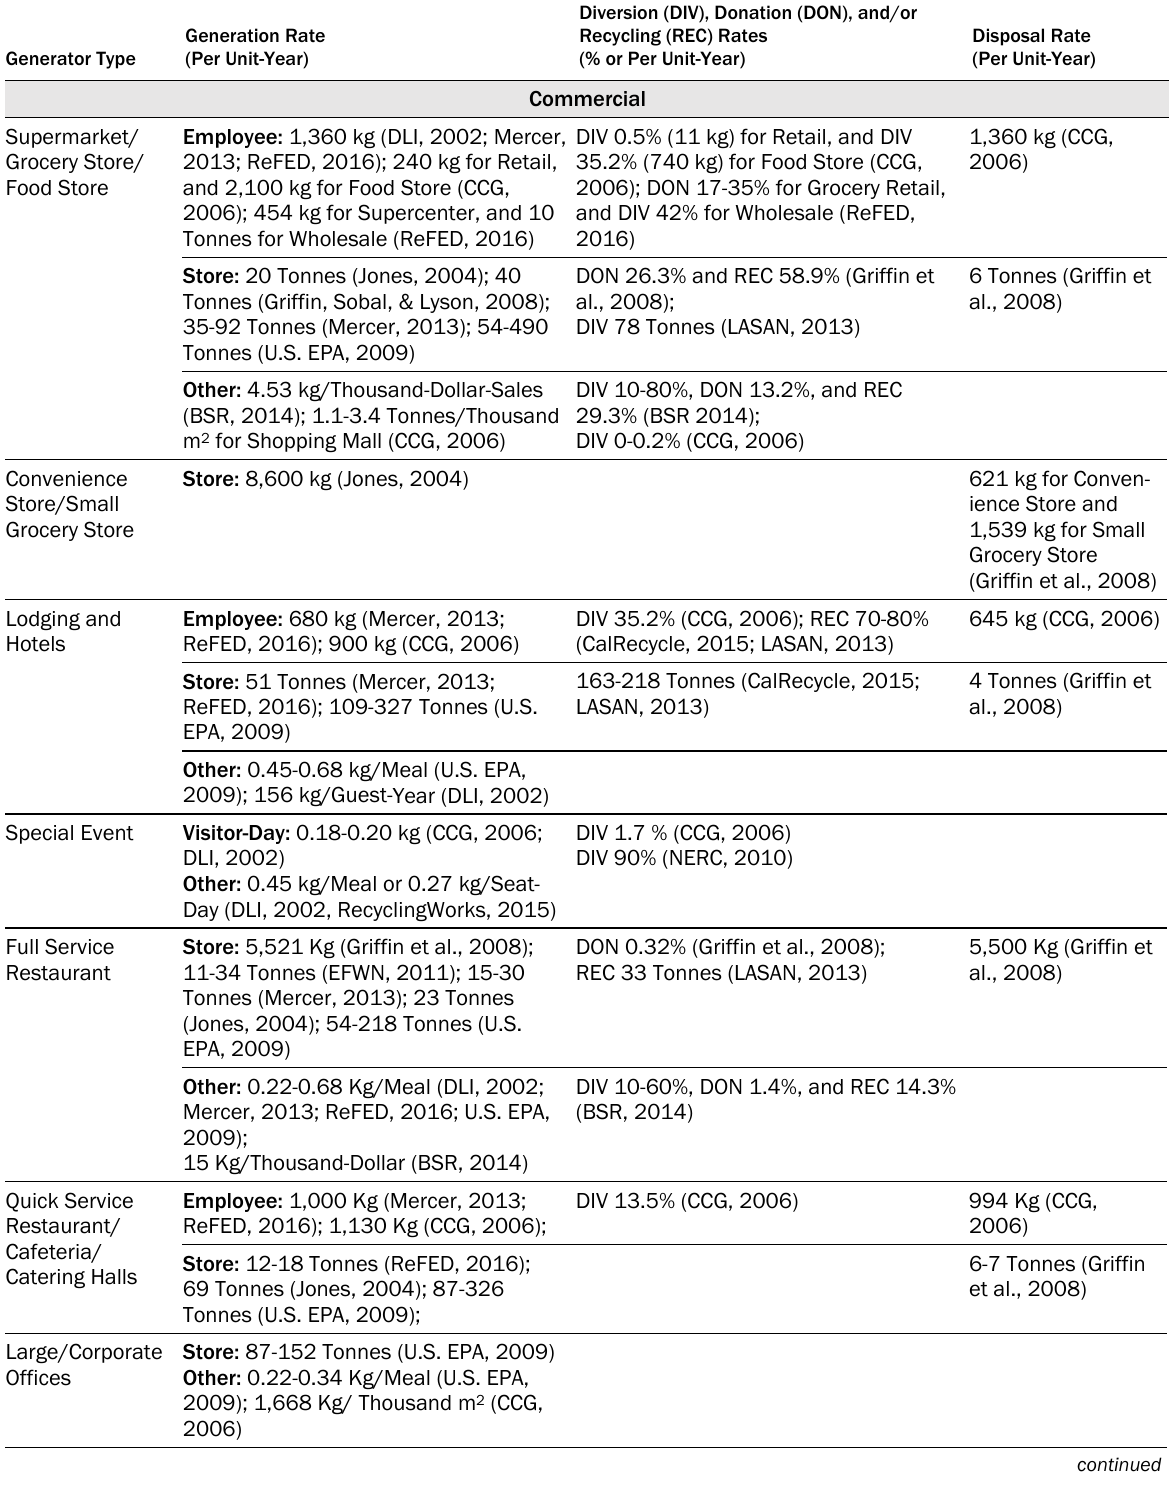
Table 1. Review on Food Waste Parameters by Generator Type